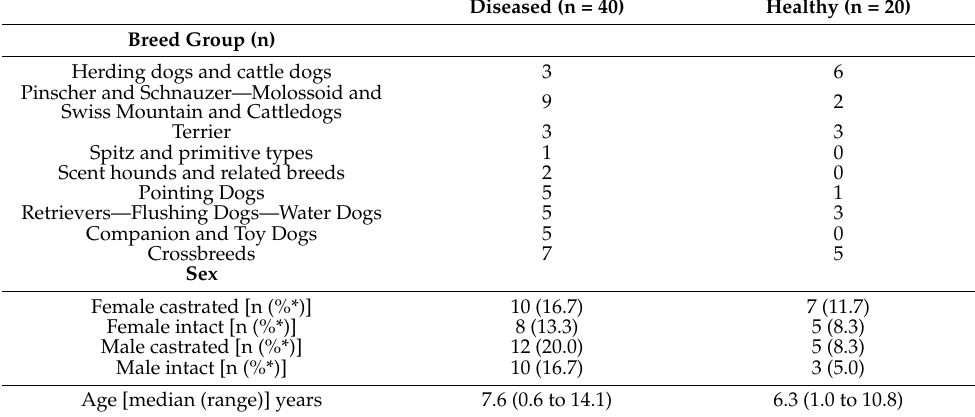
Table 1. Patient